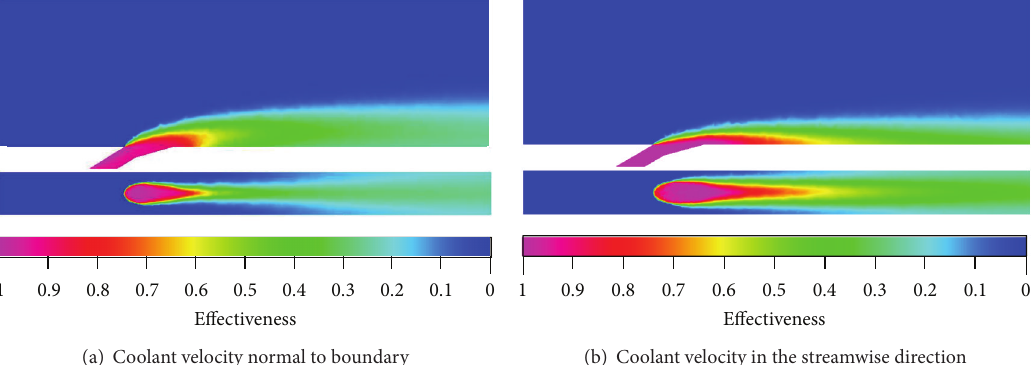
Figure 18: Top and symmetric planes of LFDSA 15-15, 𝑀 = 2 for different coolant velocity direction.